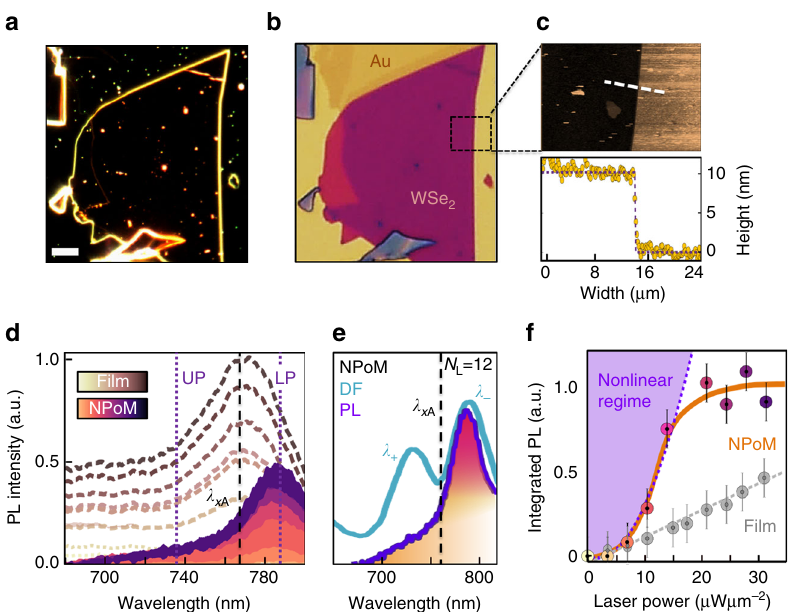
Fig. 2 WSe 2 stack properties. a Dark- fi eld image with 10 μ m scale bar (solid white line), b Bright- fi eld and c AFM images of multilayer WSe 2 stack. The AFM height pro fi le of fl ake edge (white dashed line) gives d = 10 ± 0.4 nm, corresponding to 12 layers. d Power-dependent emission (Input power ranges from 0 to 30 μ W μ m − 2 in steps of 2.5) at room temperature of the multilayer stack (brown) and NPoM (purple). Vertical lines mark A exciton absorption peak (black) and polariton peaks (purple). e Scattering and PL emission spectra on same NPoM, dashed line marks exciton absorption peak. f Scaling of integrated emission intensity with pump power for polaritons (orange curve) in NPoM (background subtracted) and (grey) excitons in multilayer on Au substrate. Error bars result from experimental noise and are extracted from the standard error of the background counts. Purple shading